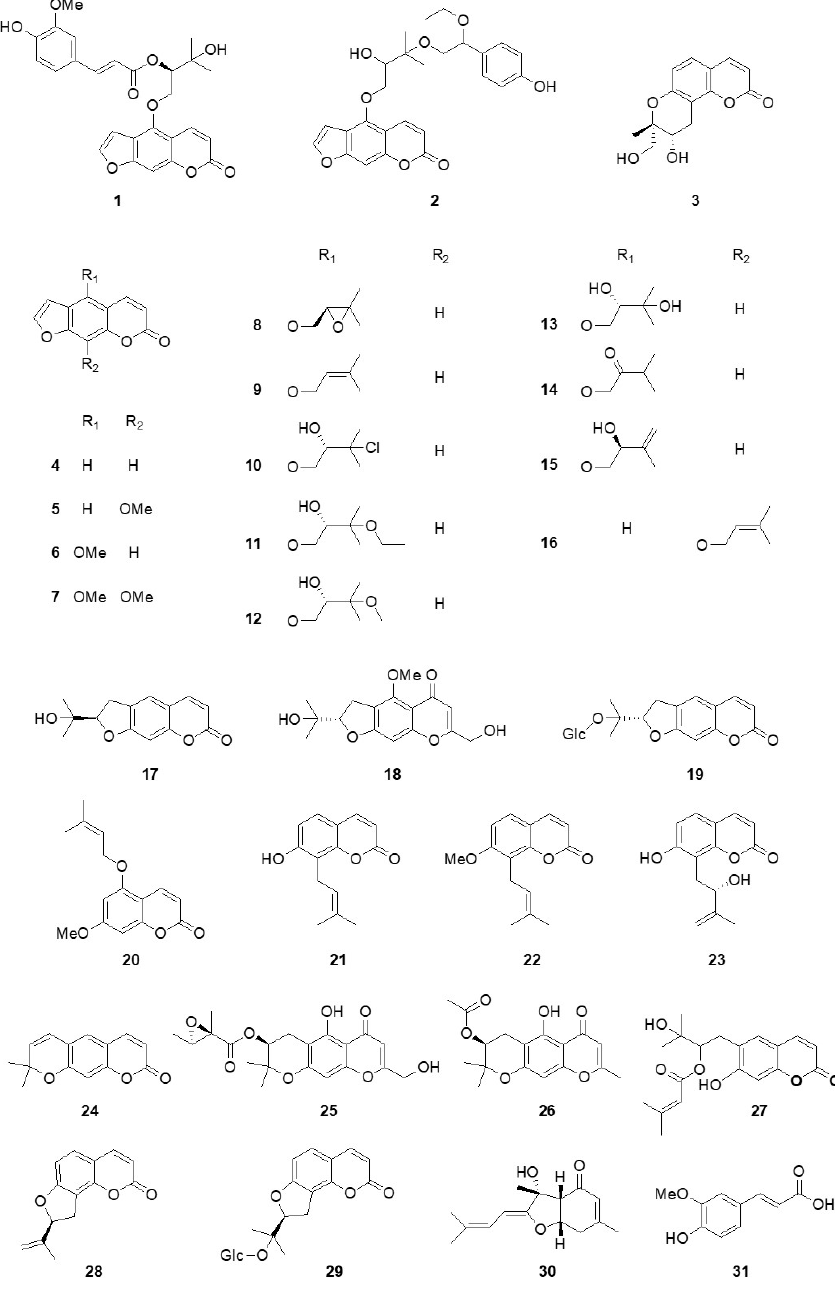
Figure 1. Chemical structures of compounds 1 – 31 from the roots of A . re fl exa .